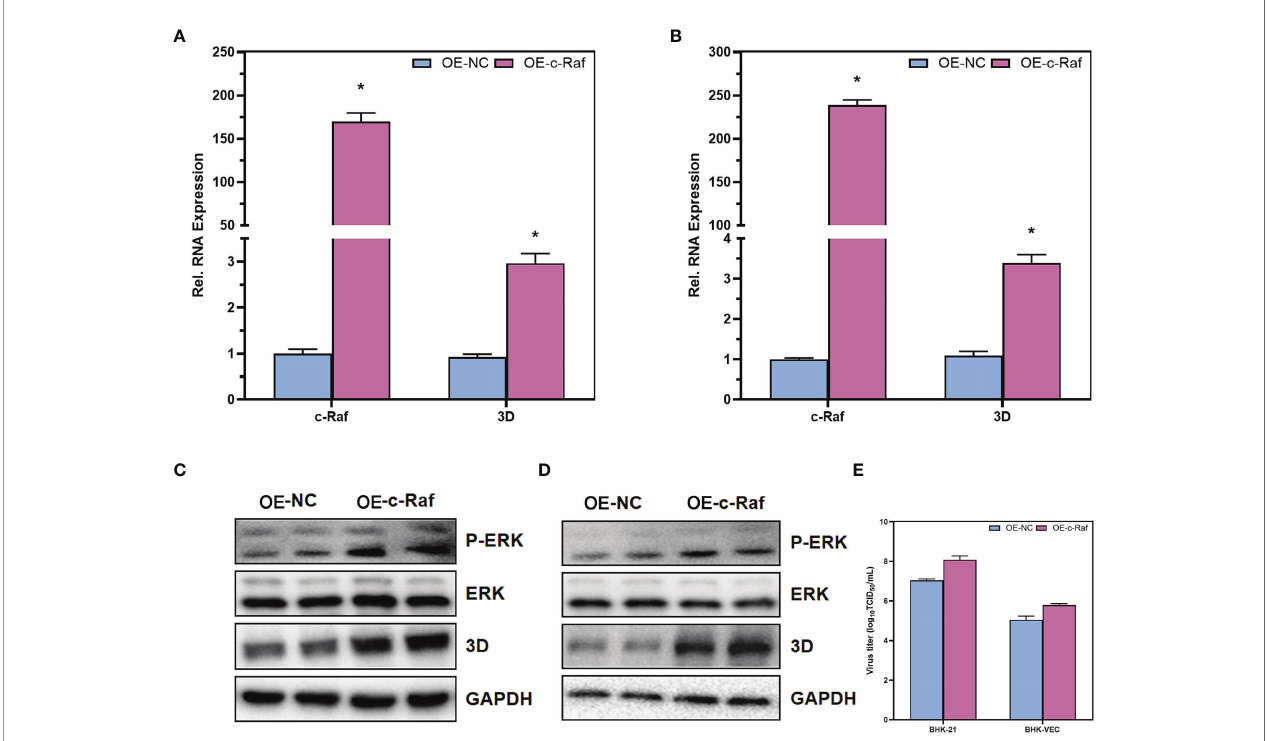
FIGURE 5 | Contributions of MAPK/ERK signaling pathway in acute and persistent FMDV infection. The RNA expression levels of c-Raf and FMDV 3D in BHK-21 cells (A) and BHK-VEC cells (B) were veri fi ed by RT-qPCR. The protein expression levels of ERK and FMDV 3D and the phosphorylation of ERK in BHK-21 cells (C) and BHK-VEC cells (D) were veri fi ed by Western blot. The infectious FMDV titers in BHK-21 cells and BHK-VEC cells (E) were veri fi ed by TCID 50 assay. OE, over expression; NC, negative control. GAPDH was served as the internal reference to normalize data. Three independent replicates were conducted for each sample. Data are expressed as the means ± SE (n = 3). * P < 0.01